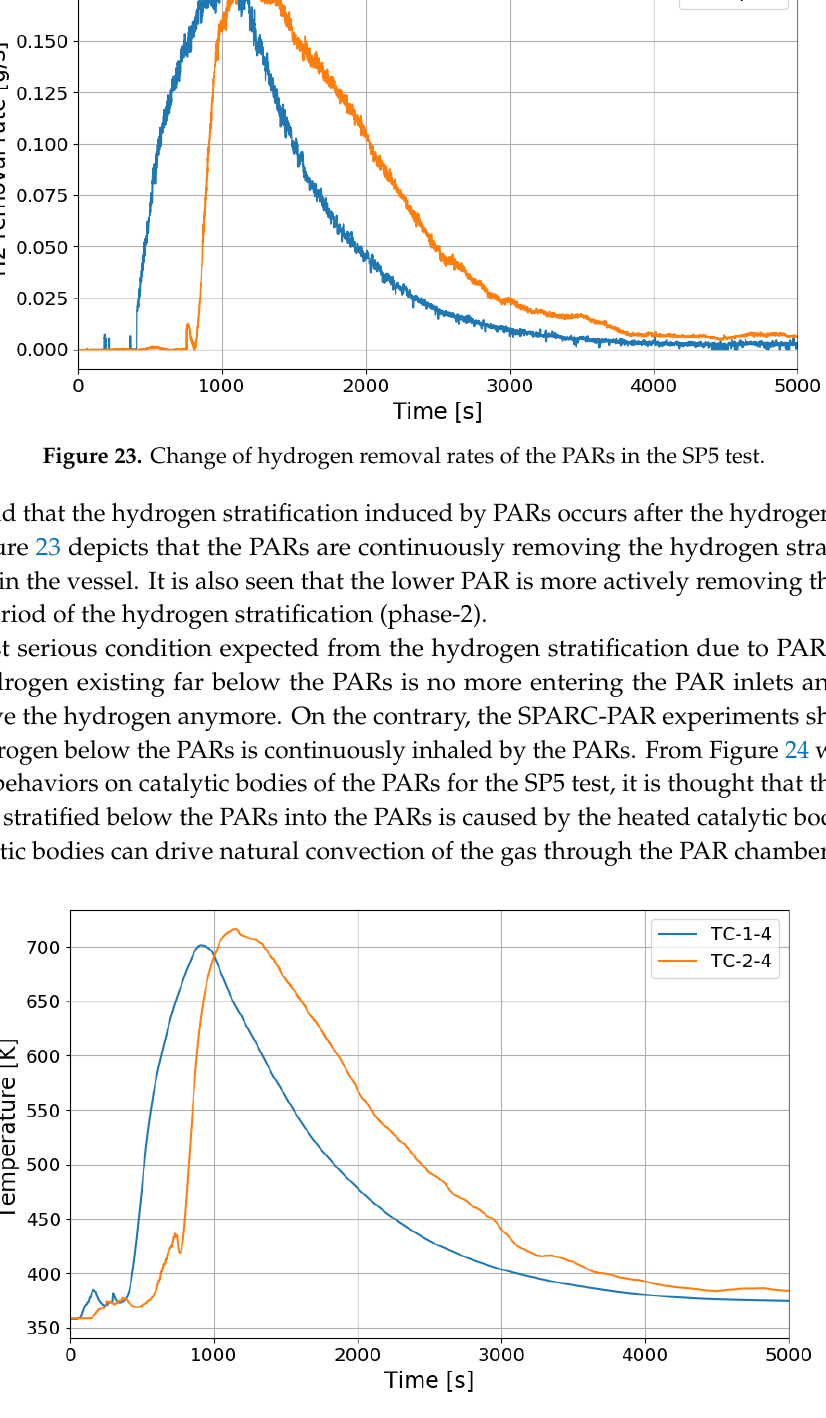
Figure 22. Gas velocities at the inlet of the PARs for the SP5 test, VWV ‐ 01: the right upper PAR, VWV ‐ 02: the left lower PAR.